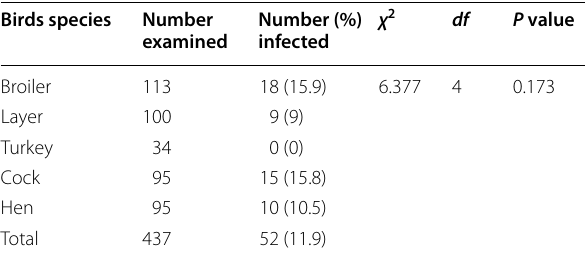
Table 3 The prevalence of Cryptosporidium oocysts according to species of bird Birds species